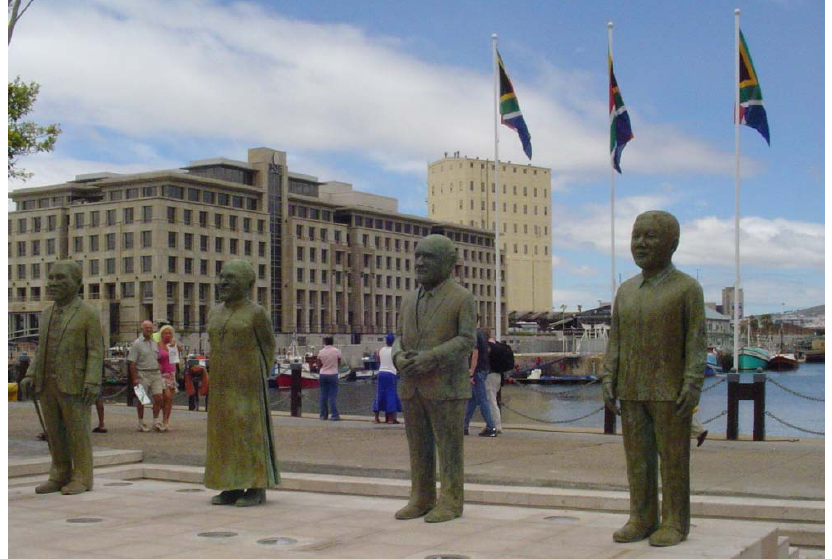
Figure 1. Commemorative sculptures of Nobel Peace Prize winners, Luthuli, Tutu, De Klerk and Mandela, by Claudette Schreuders, Cape Town waterfront (author’s